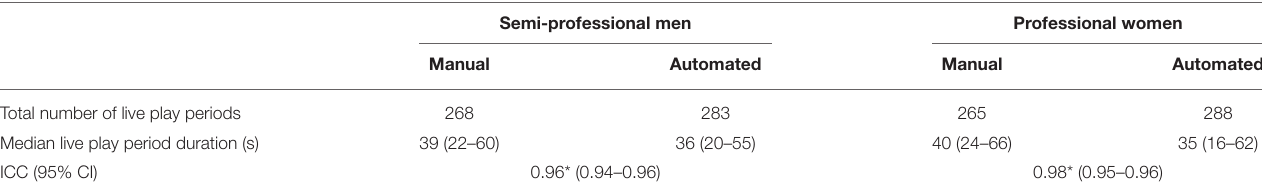
TABLE 1 | Descriptive and correlation details of the manual and automated methods.